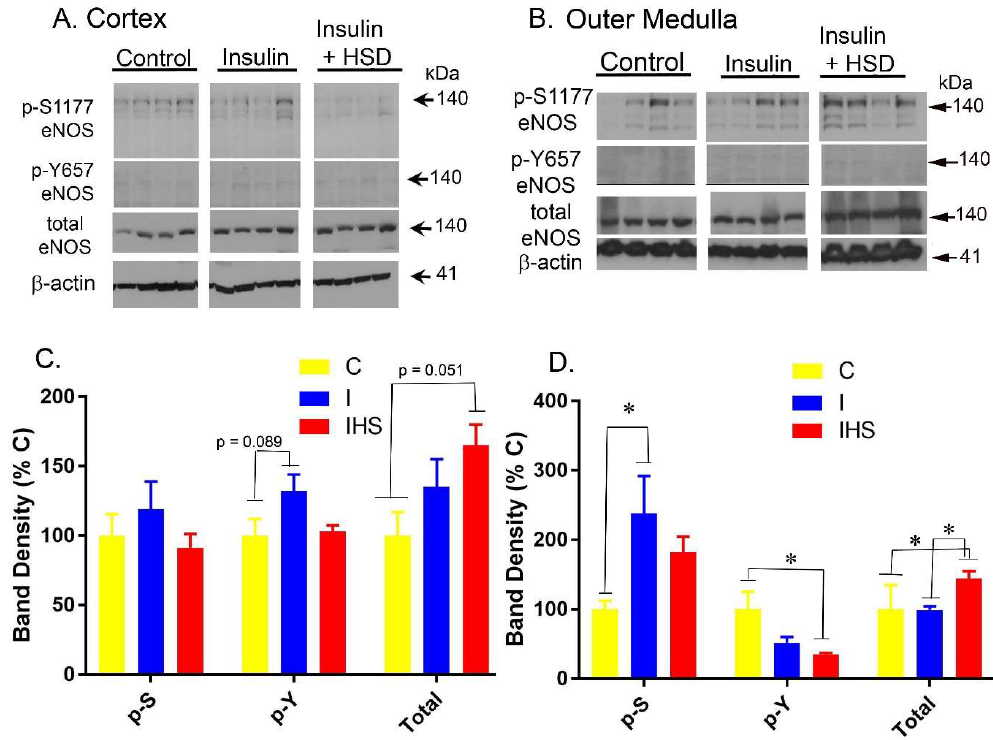
Figure 6. Western blotting for endothelial nitric oxide synthase (eNOS) protein—( A ) Representative Western blots of cortex homogenates. Separate blots were probed for p-S1177-eNOS, p-Y657-eNOS, and total eNOS. Equal amounts of protein were loaded in each lane. Summaries of band densities (normalized to β-actin) for ( B ) p-S1177-eNOS, p-Y657-eNOS, total eNOS; ( C ) Representative western blots of outer medulla homogenates. Summaries of band densities (normalized to β-actin) for ( D ) p-S1177-eNOS, p-Y657-eNOS, total eNOS; ∗ indicates a significant difference between groups by one-way ANOVA (mean ± sem; n = 8–12/group for statistics).